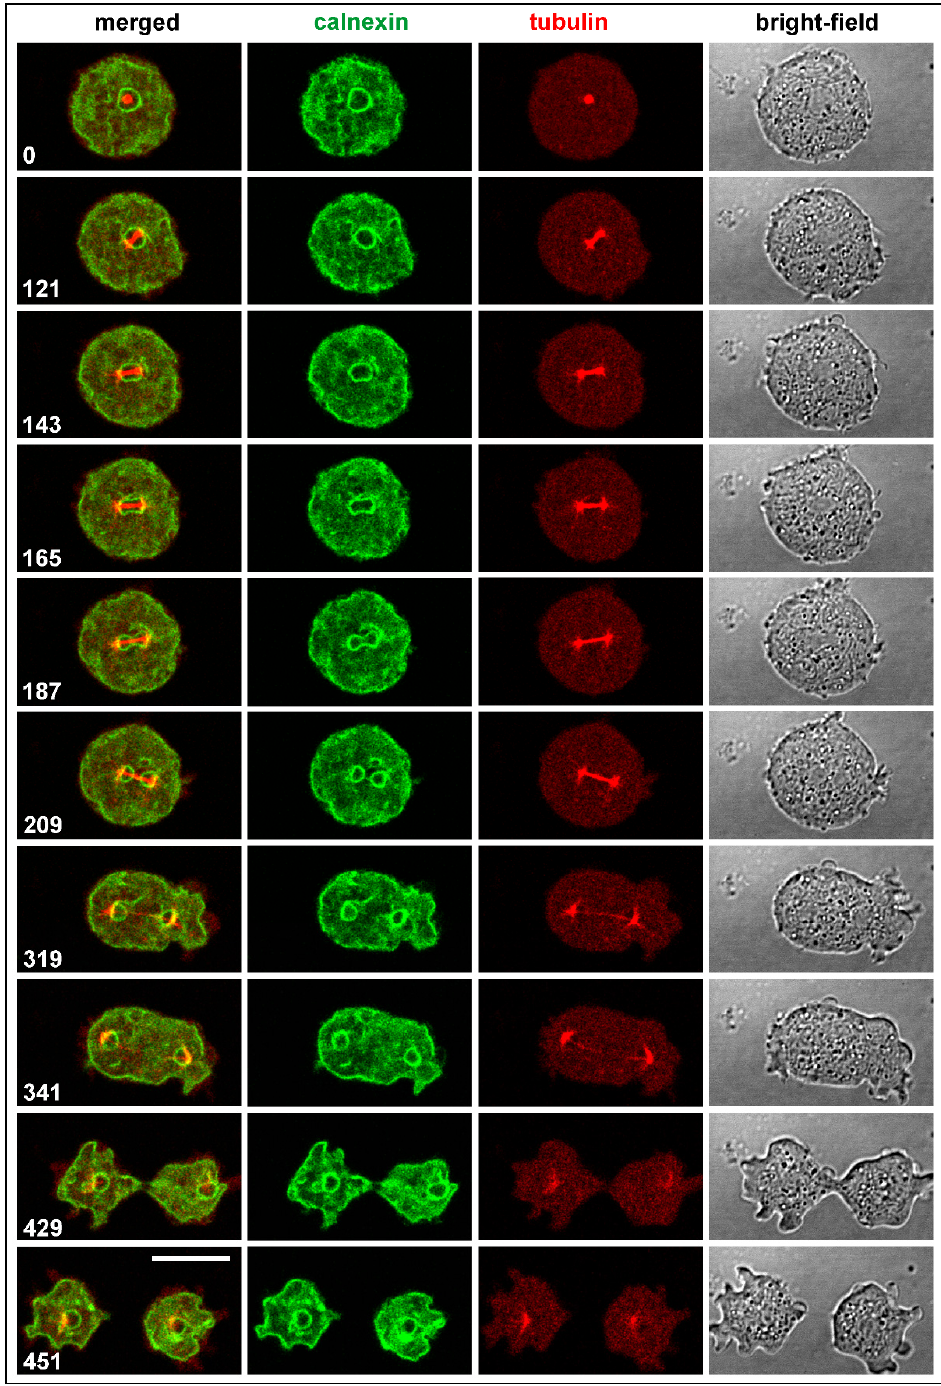
Figure 1. Normal mitosis in D. discoideum showing spindle formation and elongation relative to the outer nuclear membrane. The cell expressed GFP-calnexin to label the endoplasmic reticulum that comprises the outer nuclear membrane, and mRFP- α -tubulin to visualize the mitotic apparatus. Panels show from left to right: merged fluorescence images displaying the Calnexin label in green and the α -tubulin label in red; the Calnexin label separately; the α -tubulin label; and confocal bright-field images of the dividing cell. This sequence is also shown in Video S1. Time is indicated in seconds. Bar, 10 µm.